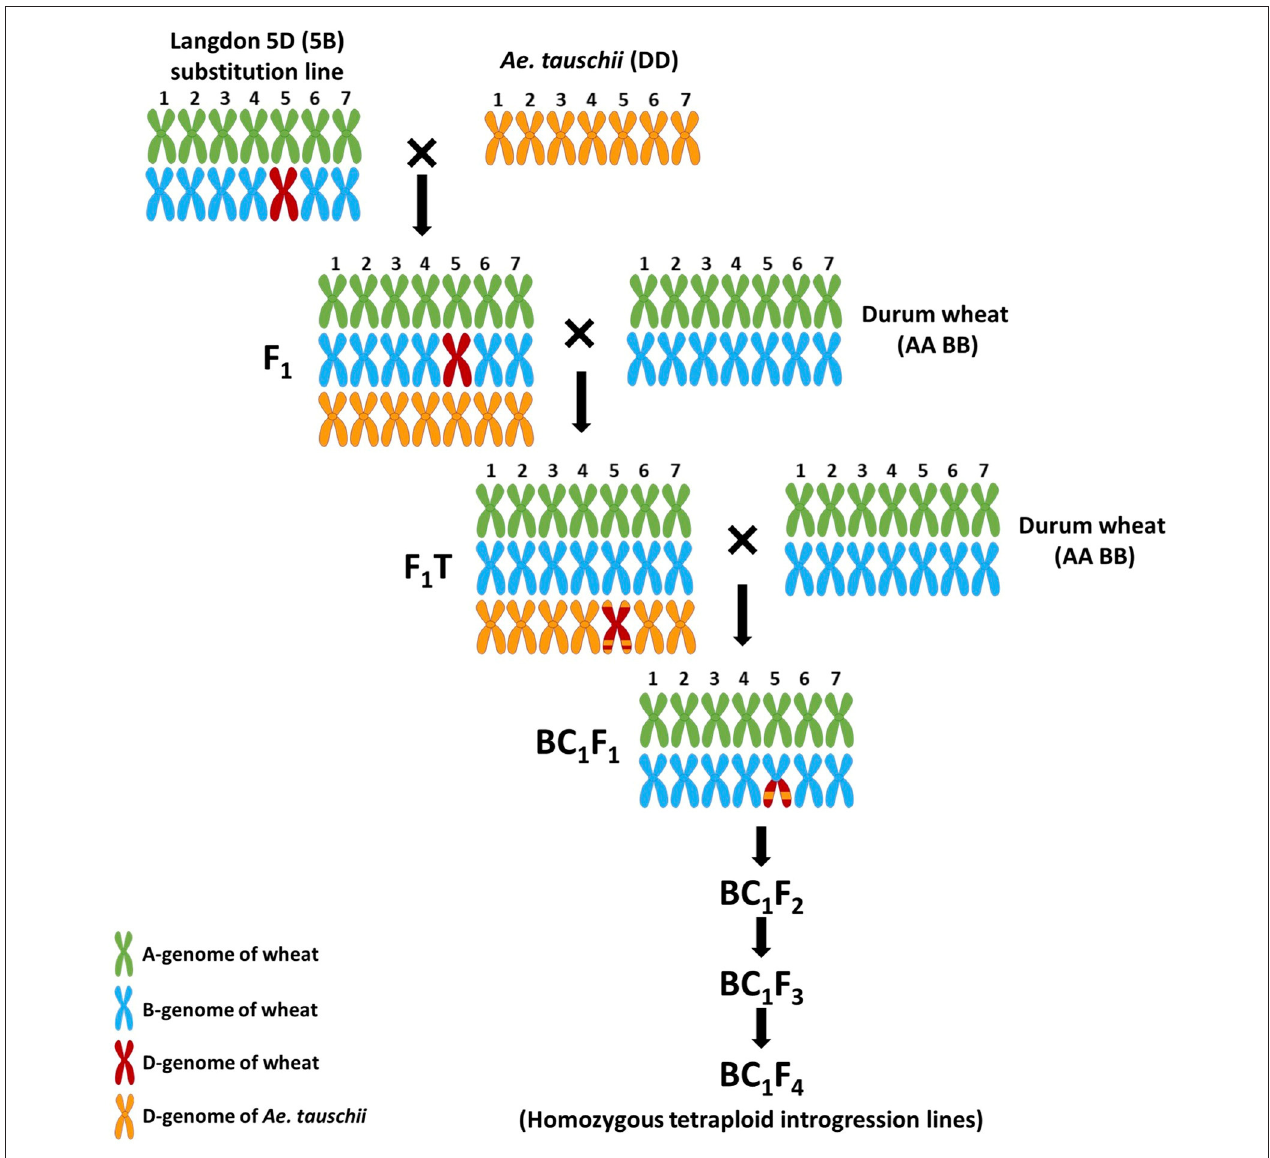
FIGURE 1 | Crossing diagram of Ae. tauschii introgression into durum